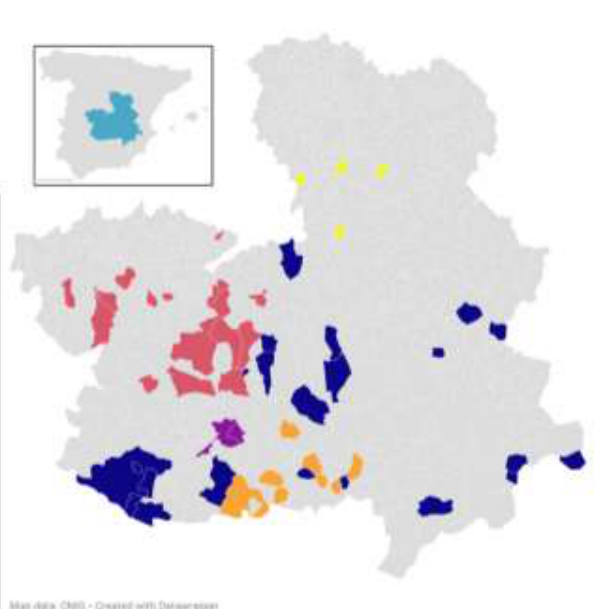
Figure 2. Location of the olive oil mills included in the study. Different colors indicate membership of different PDOs. Yellow is for PDO Aceite de La Alcarria ; red is for PDO Montes de Toledo ; purple is for PDO Aceite Campo de Calatrava ; orange is for PDO Aceite Campo de Montiel and blue for oils mills without PDO certification.